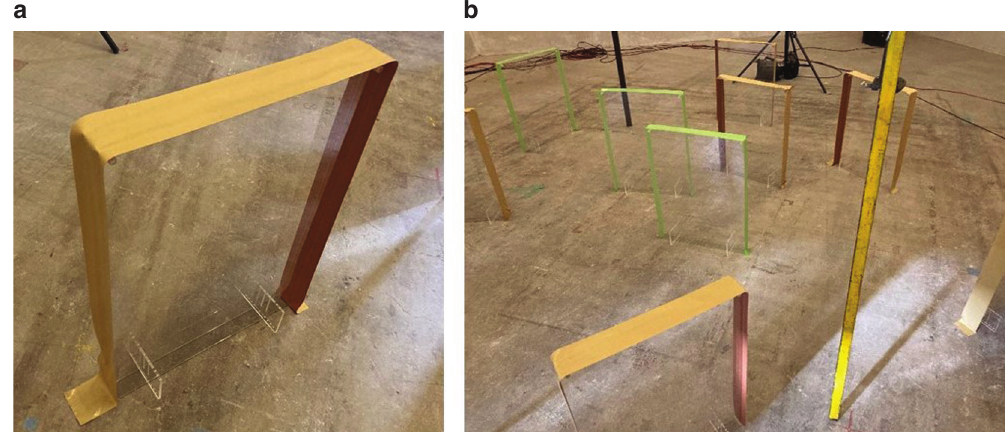
(a) Photograph of Specimen (b), and (b) photograph with the same specifications as Specimen A but with its periphery wrapped by adhesive tape.